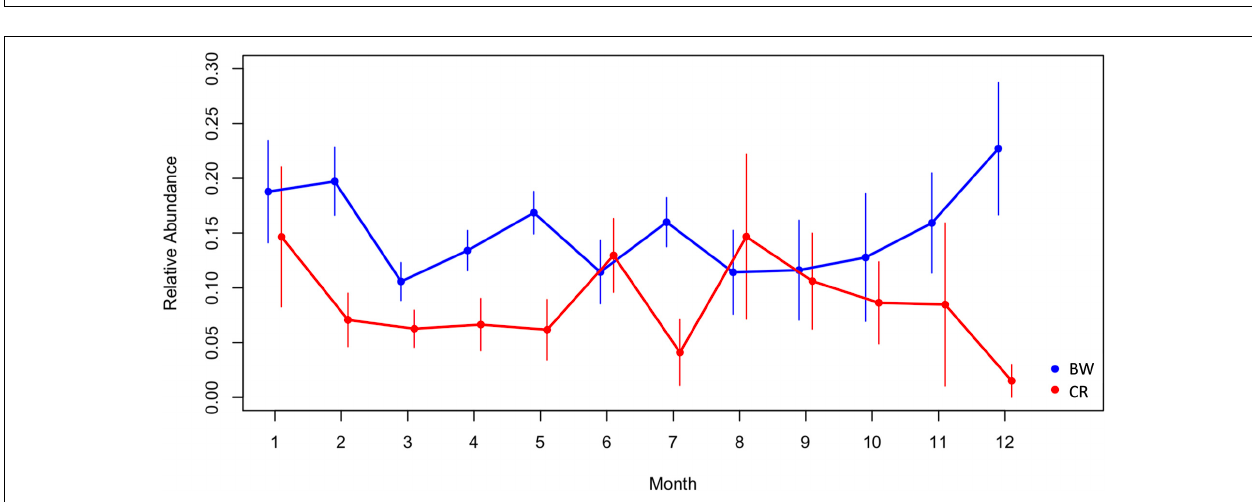
FIGURE 4 | Response curves showing the relationship between the probability of occurrence of BW and CR various habitat and life-history parameters. The order of the response curves is by the importance of the variable. Distances are shown in meters. Habitat variables (e.g., managed tree cover) are shown as percentage values. LHP refers to the larval host plant. The dotted lines are 95% confidence intervals.